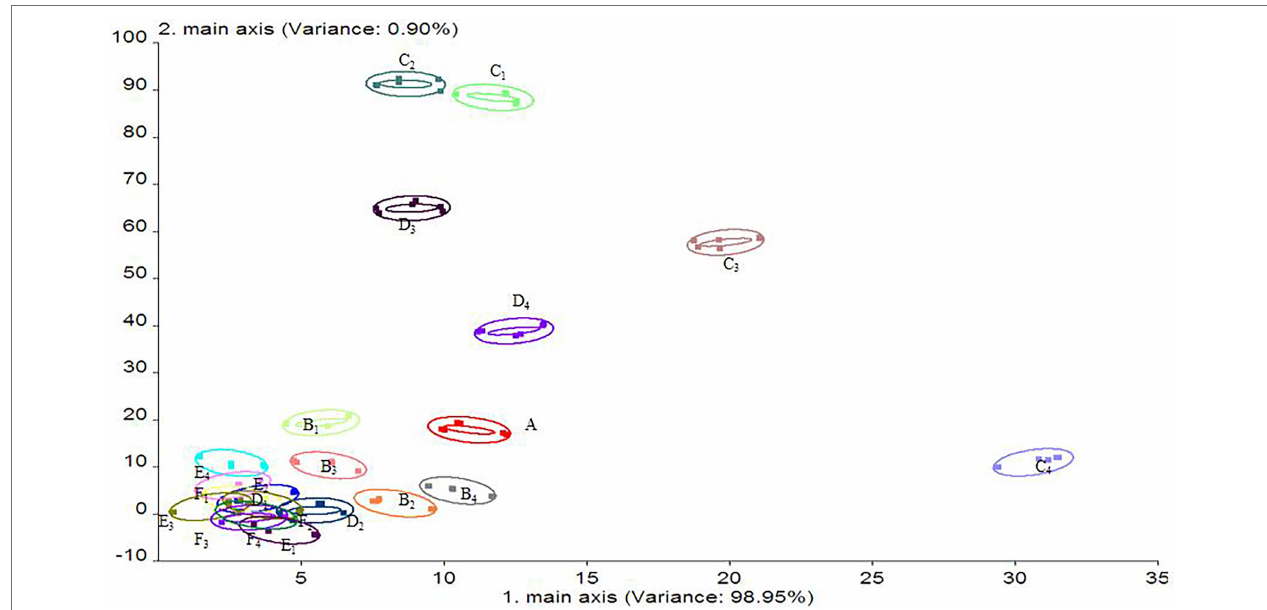
FIGURE 11 | Principal component analysis of salmon flavor. A, B, C, D, E, and F represent 0, 4, 8, 12, 16, and 20 days salmon samples, respectively; subscript 1 represents the food tinfoil group; subscript 2 represents the PCL group; subscript 3 represents 20% LL/PCL group; subscript 4 represents 40% LL/PCL